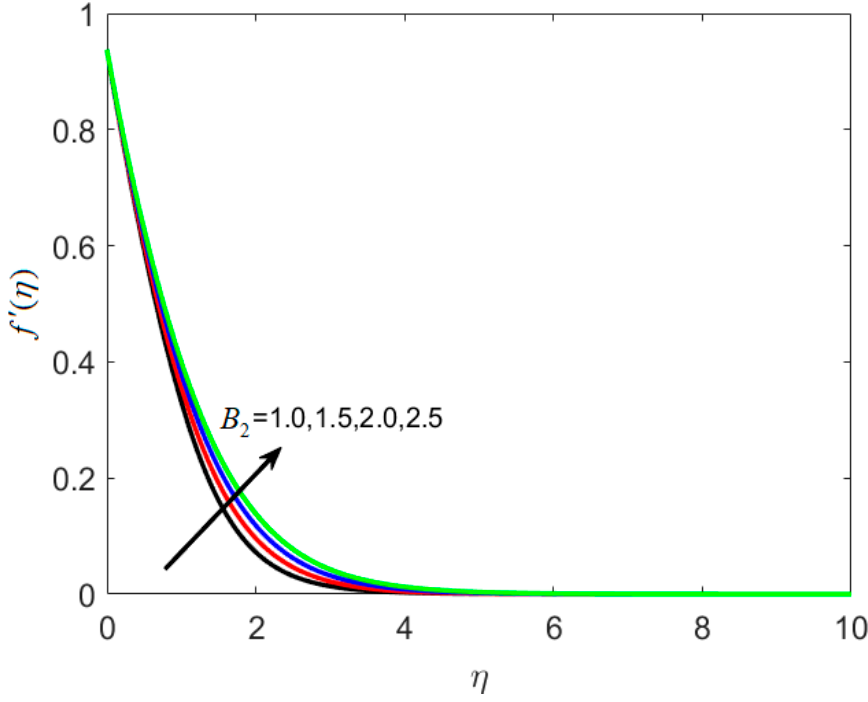
B by taking Figure 3. Various estimates of second material parameter B 2 by taking B 1 = 1.2, S t = 0.3, λ h =